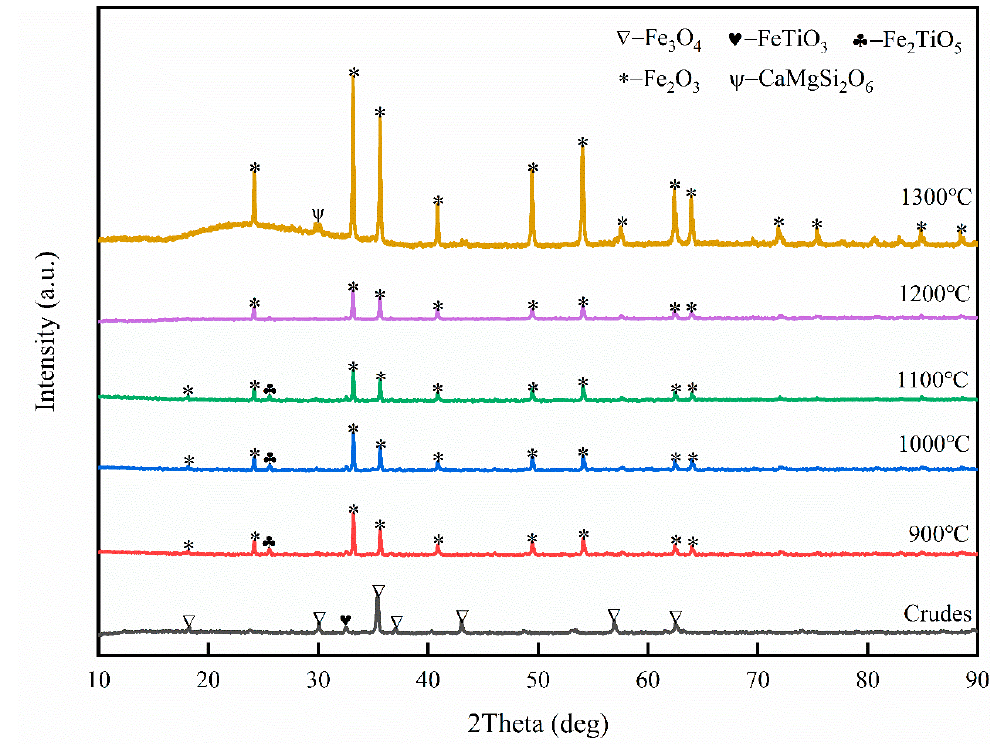
Figure 5. XRD pattern of pellet samples.